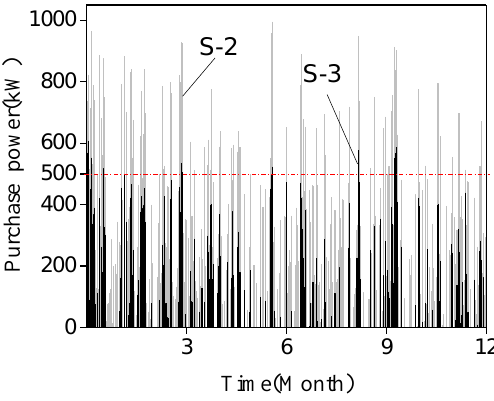
Figure 8. Power demands from the microgrid to the utility grid.